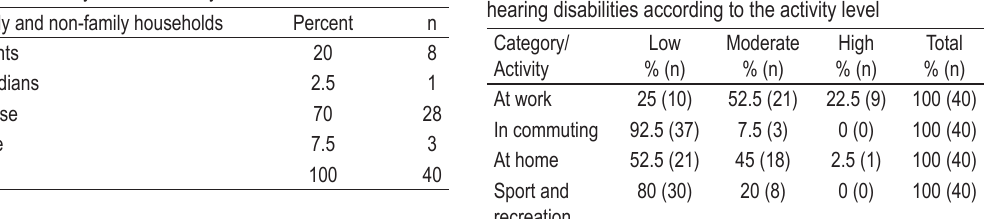
TABLE 11. Classification of individuals with speech